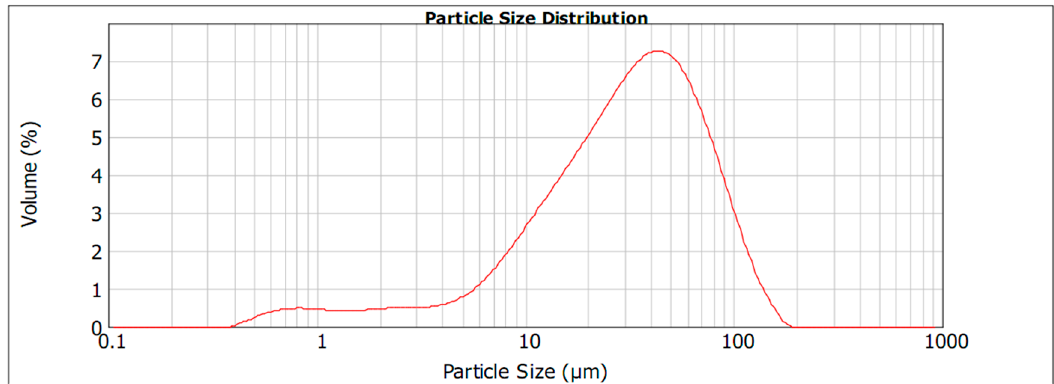
Figure 1. The particle size distribution of the powdered printed circuit board (PCB) sample.